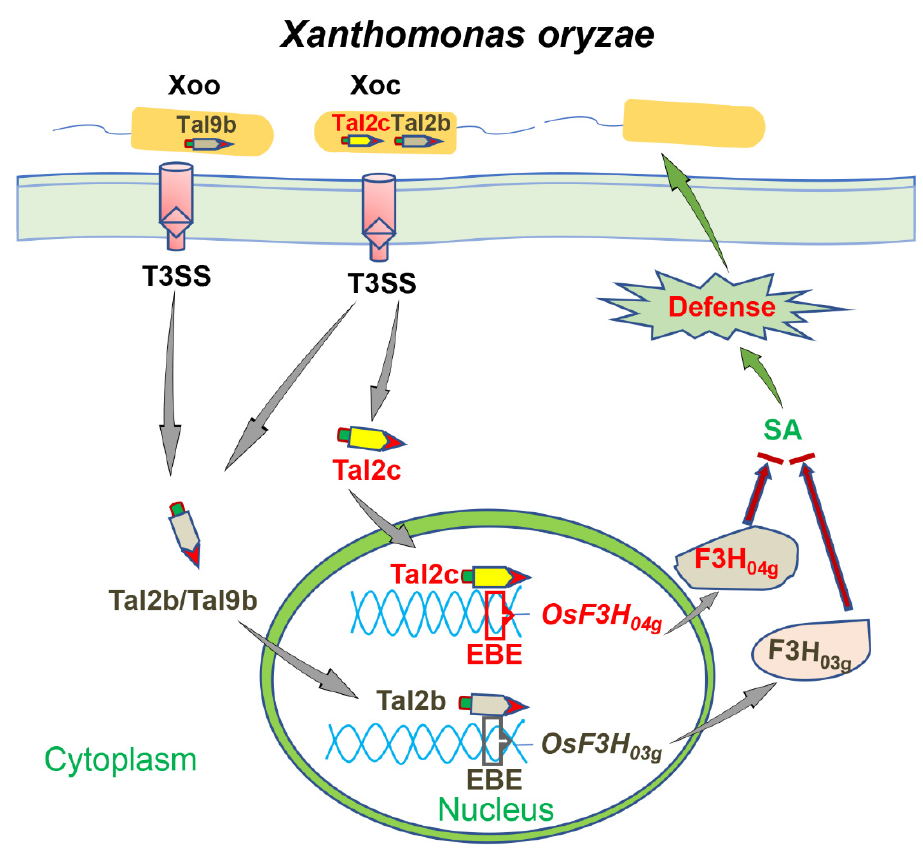
Figure 7. Working model of redundant Tal2b and Tal2c from Xanthomonas oryzae pv. oryzicola . Xoc delivers two TALEs, Tal2b and Tal2c, into rice cells using a type III secretion system (T3SS). Tal2b and Tal2c then enter the nucleus to directly bind to EBEs of the 2-oxoglutarate-dependent dioxygenase (2OGD) genes OsF3H 03g and OsF3H 04g promoters and activate gene expression, respectively. However, Xanthomonas oryzae pv. oryzae delivers only a Tal2b homologue, Tal9b, to directly bind to EBE of OsF3H 03g promoter to promote infection. Finally, OsF3H 03g and OsF3H 04g work as similar functions in the negative regulation of defense and SA content in rice against Xoc.